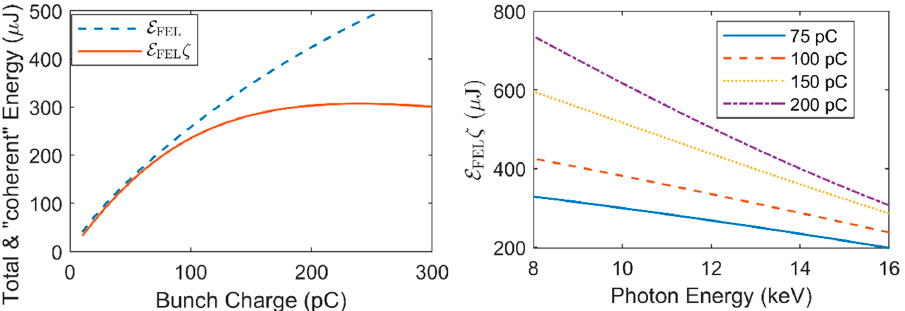
Figure 10. Left: total FEL pulse energy and fraction of transversely coherent pulse energy vs. bunch charge, at the photon energy of 16 keV. Emittance scaling with charge as in Equation (4) is assumed. Right: fraction of transversely coherent pulse energy vs. photon energy, at several bunch charges.